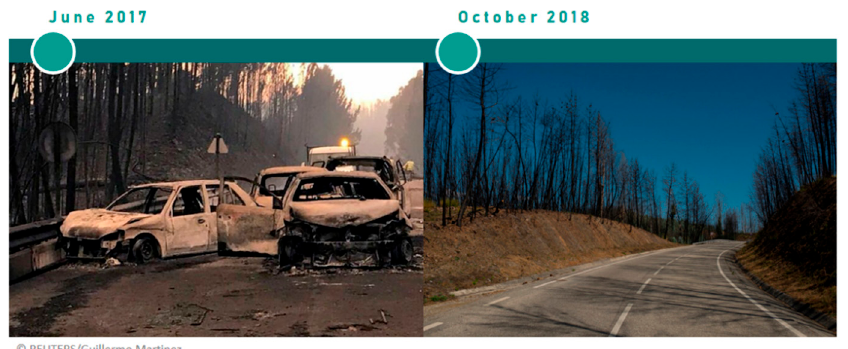
Figure 3. The EN236-1, Death Road , immediately after the forest fire in June 2017 (REUTERS ® ) and more than a year later in October 2018 (The provided pictures do not depict the exact kilometer of the EN236-1).